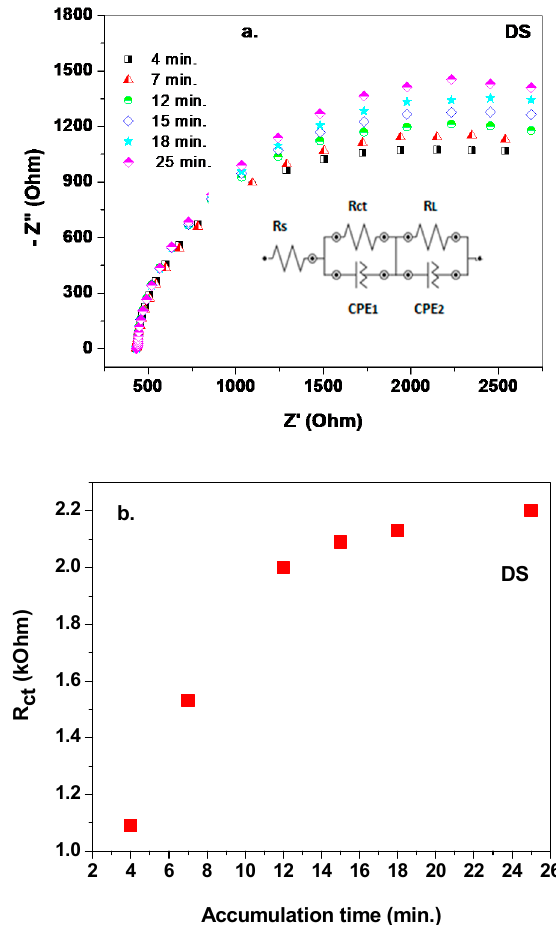
Figure 7. Nyquist plots recorded over time with the bare DS electrode in pH 7.6 PBS solution containing 0.07 mg / mL CA199-His; applied potential: + 1.1 V; 0.1–10 6 Hz frequency range ( a ); inset: electrical equivalent circuit employed for fitting the recorded EIS data; Variation of R ct with the accumulation time ( b ).